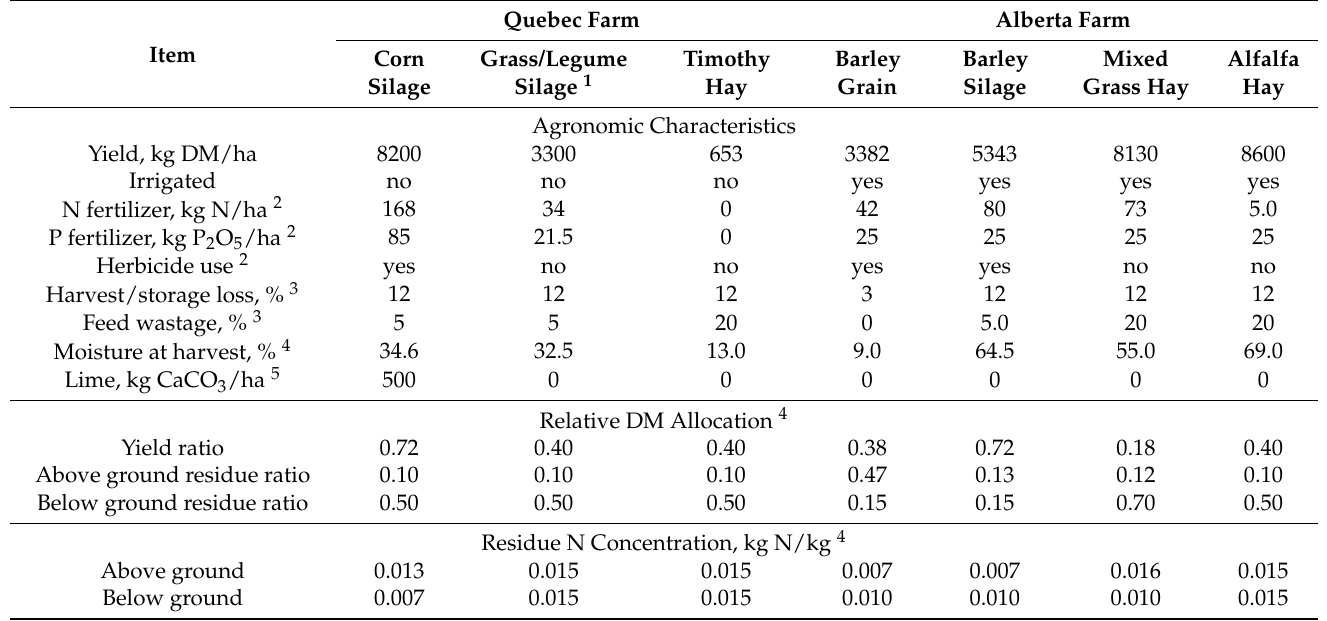
Table 3. Characteristics for farm-grown crops for the simulated dairy